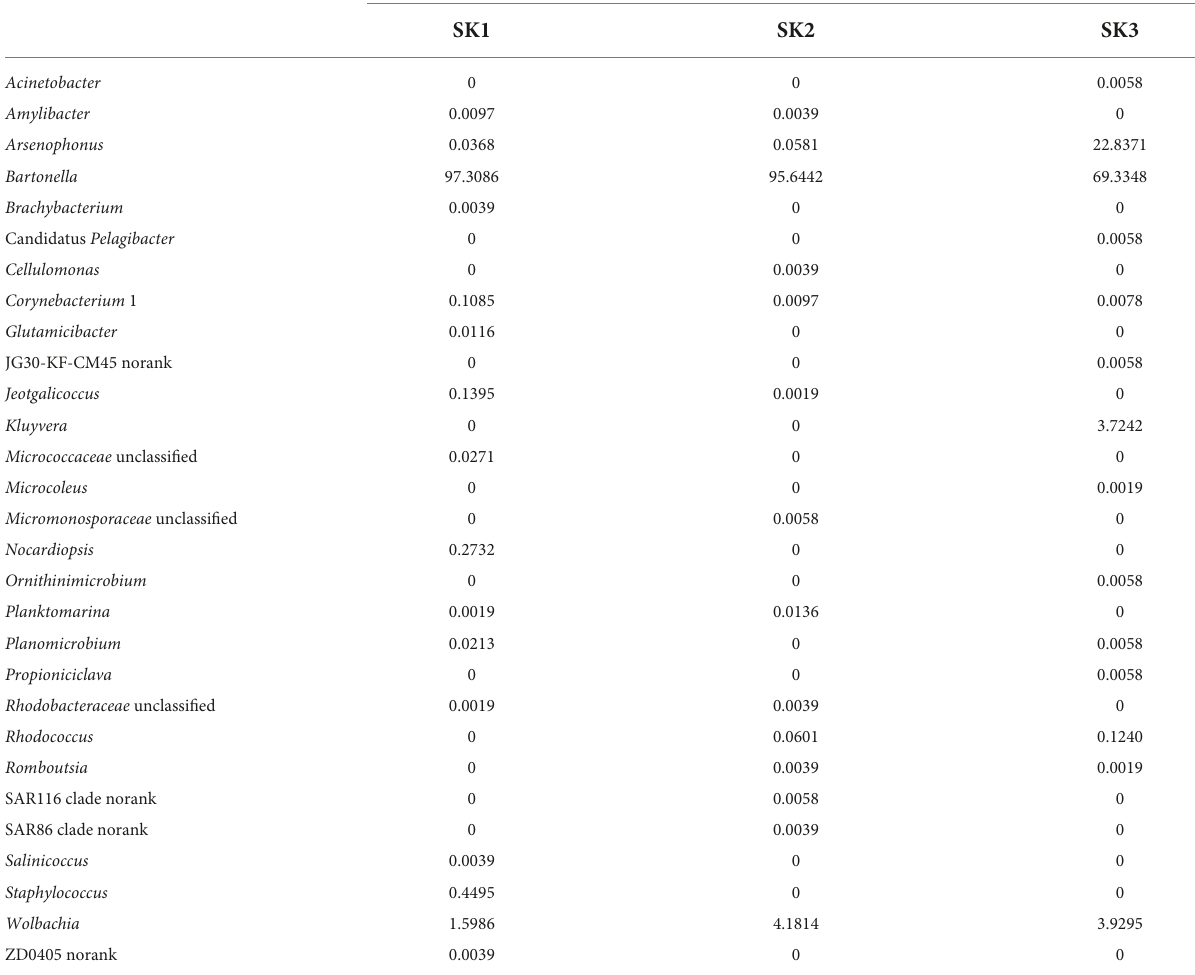
TABLE 2 The relative abundance of 29 bacterial genera in the 3 samples.